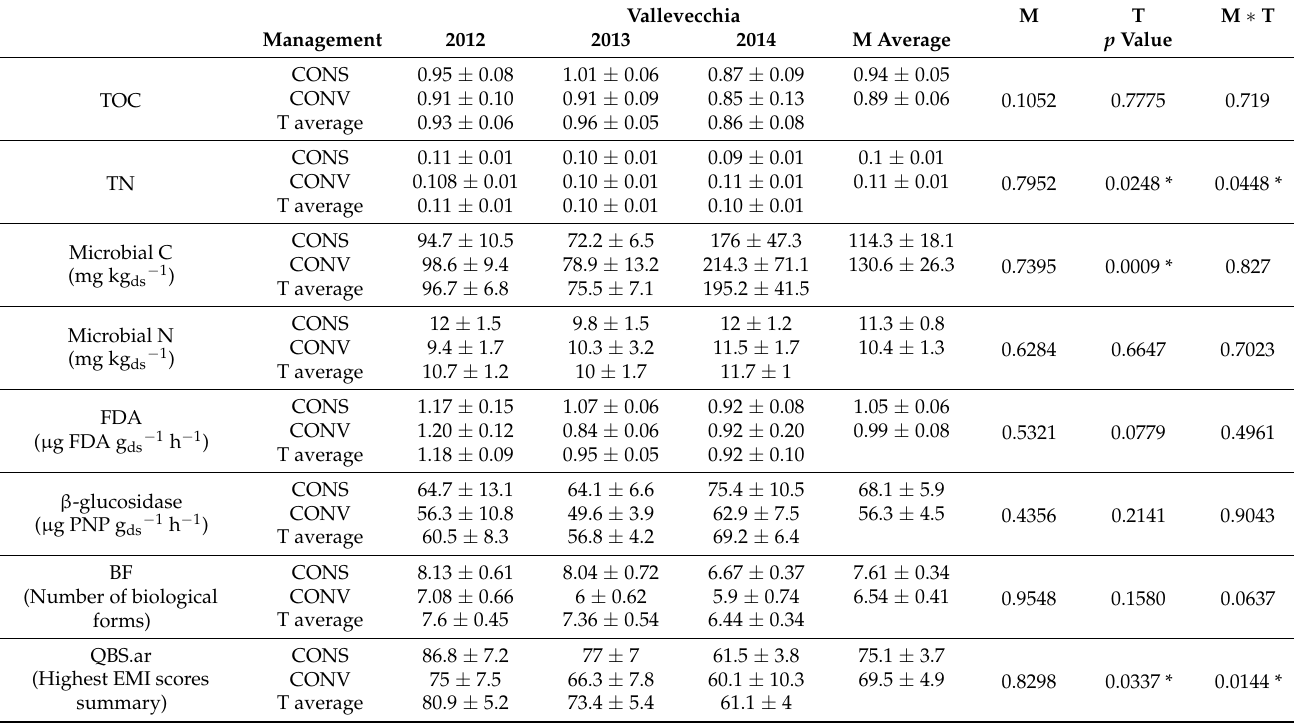
Table 5. Soil evolution in Vallevecchia